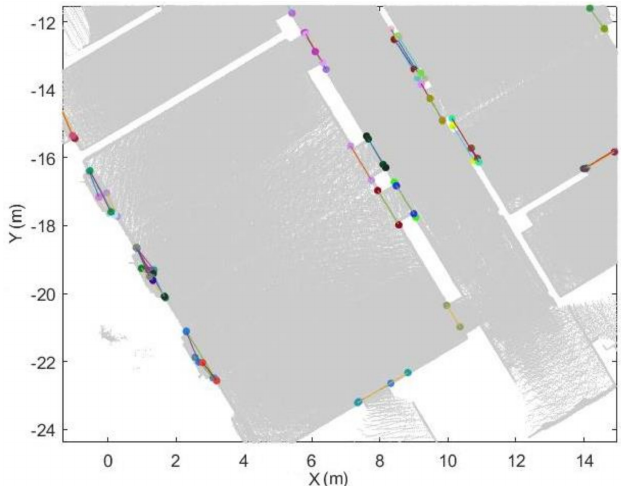
Figure 11. Example result of Step 2 (each opening candidate shown in a different